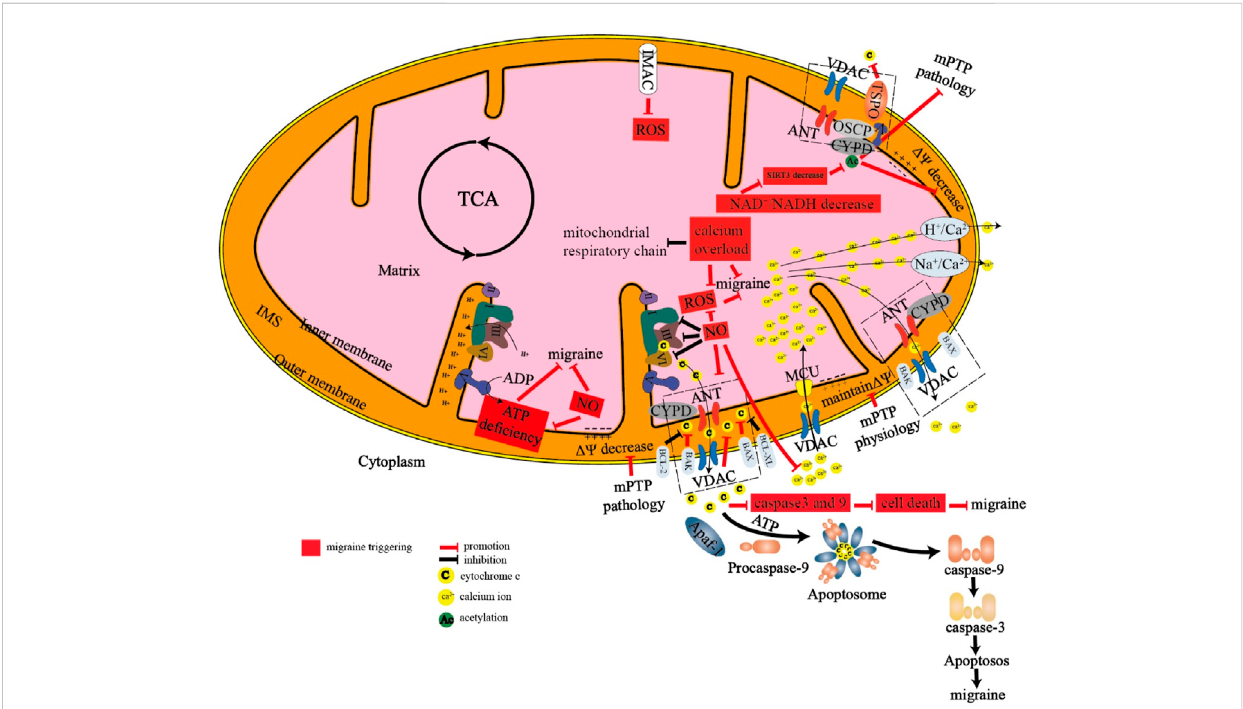
FIGURE 2 Mechanism of energy metabolism in mitochondria there are many proteins and protein channels on the inner membrane and outer membrane of mitochondria. When energy metabolism is abnormal, the following abnormalities will occur in mitochondria, which eventually lead to migraine. 1. mPTP andIMACarepathologicallyopen,resultinginthereleaseofcytochromeCandreactiveoxygenspecies.2.Alargenumberofcalciumionsin fl owthrough the MCU channel, resulting in calcium overload in the mitochondria. 3. The dysfunction of the mitochondrial respiratory chain leads to the production of reactive oxygen species and insuf fi cient production of ATP, which will stimulate the production of nitric oxide. 4. The decrease of NAD+/ NADH can leadto thechange ofSIRT3, CYPD, and otherproteins,and fi nally leadto thedecrease ofmitochondrial membrane potential and theopening of mitochondrial permeability transition pore. 5. Abnormal proportion of pro-apoptotic proteins and anti-apoptotic proteins can lead to apoptosis and eventually lead to